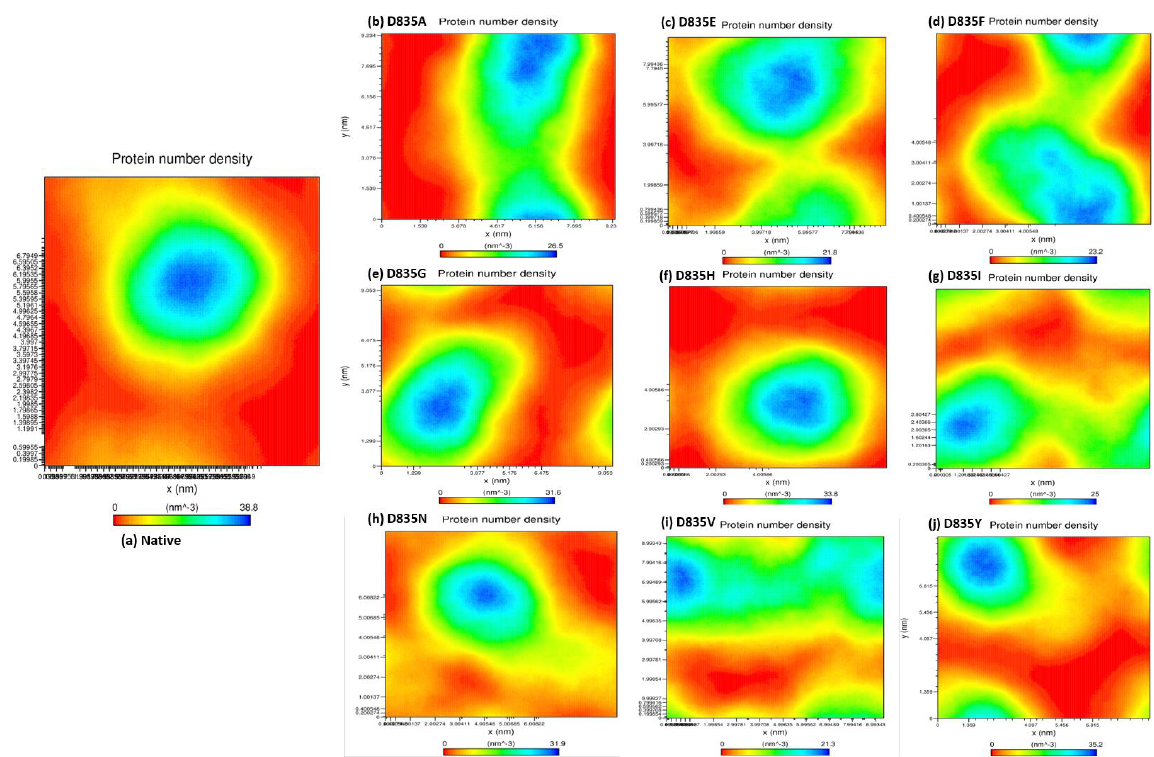
Figure 6. The atomic density distribution of native and mutant FLT3 structures for the period of 200 ns. ( a ) Native; ( b ) D835A; ( c ) D835E; ( d )D835F; ( e )D835G; ( f )D835H; ( g )D835I; ( h )D835N; ( i )D835V; ( j ) D835Y.